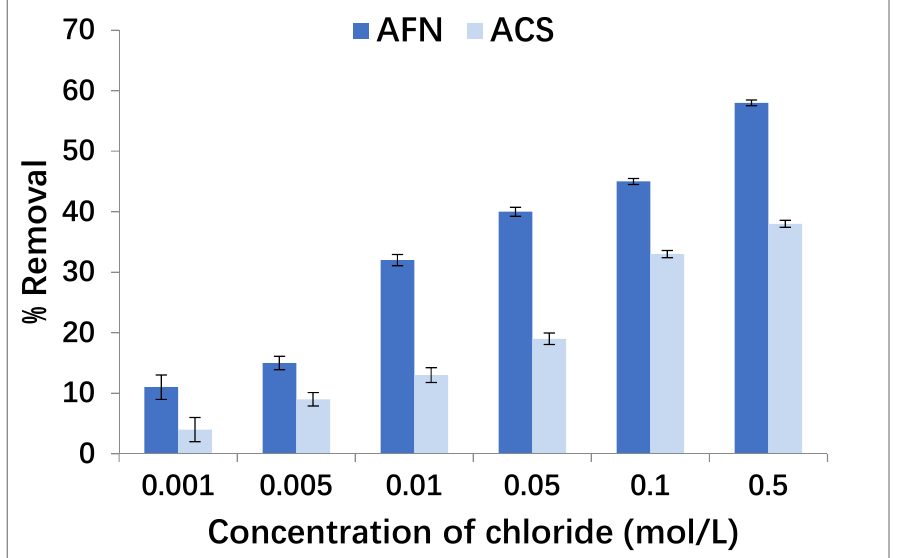
Figure 3. Effect of chloride concentration in the receiver compartment (pH 11.5, boron concentration 50 mg/L in the feed compartment, stirring speed of 500 rpm and temperature 25 °C).